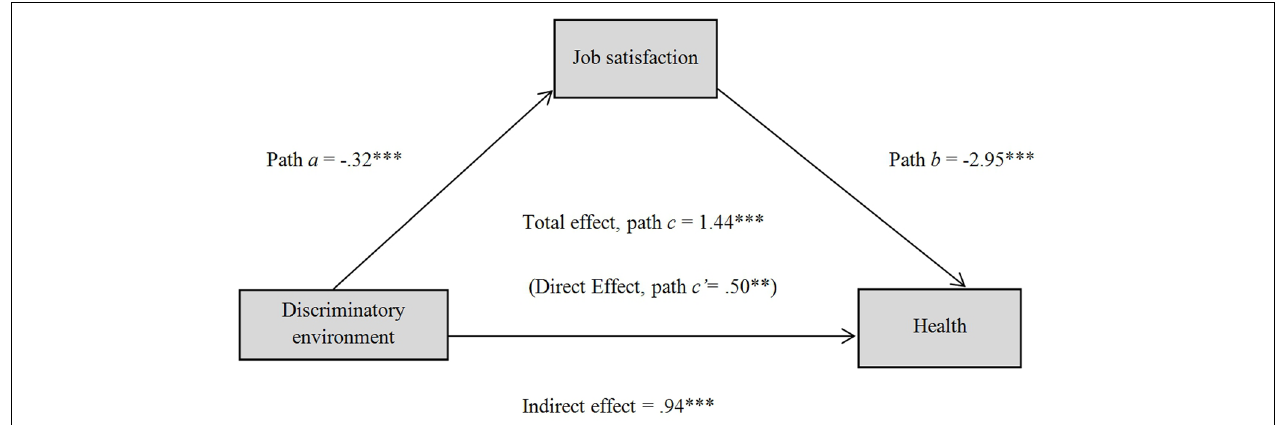
FIGURE 1 | Mediating effect of job satisfaction on the association between discriminatory environment and health ( ∗∗ p < 0.01; ∗∗∗ p <